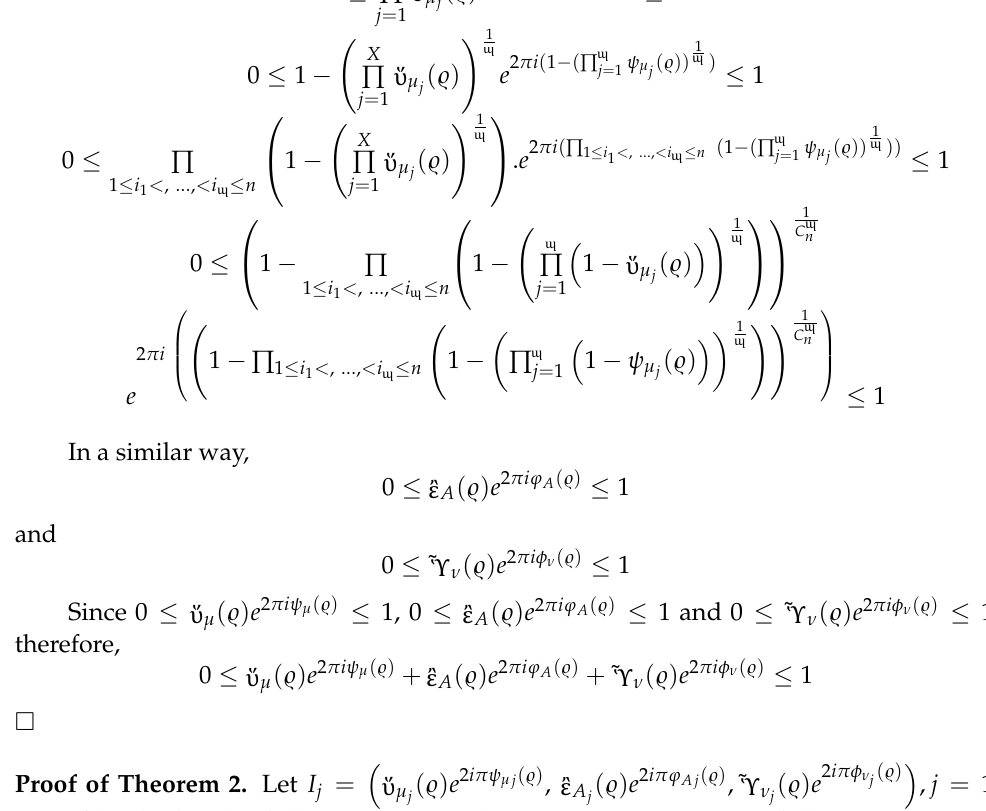
Table 1. Symbols and their meanings.